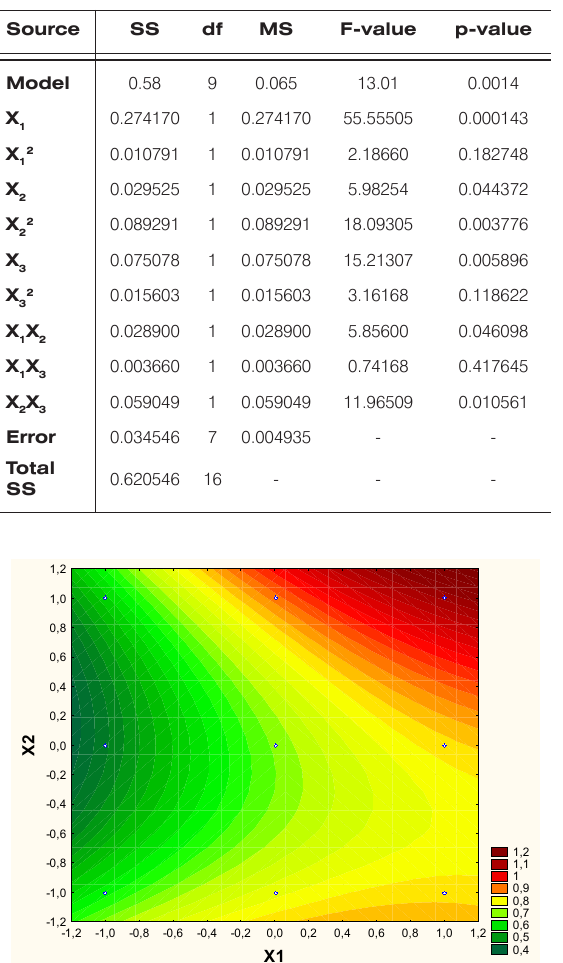
Table 3. Analysis of variance.